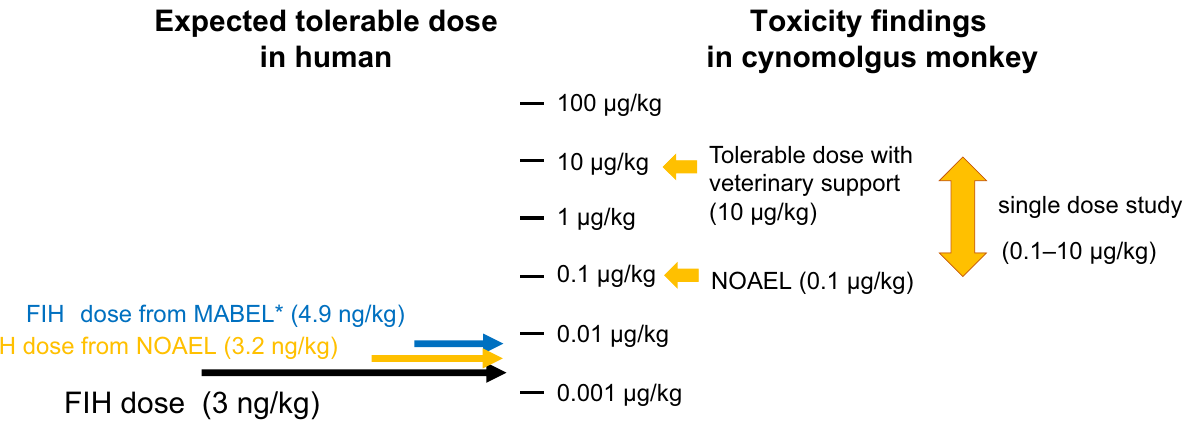
Figure 5. Calculation of the FIH dose from MABEL and NOAEL. The FIH dose from MABEL and NOAEL. The FIH dose from MABEL was calculated as the dose at which the C max after 4 h of i.v. infusion of ERY974 is equal to the EC 10 value of cytotoxicity assay, combining PK data, and the FIH dose from NOAEL was calculated considering species differences. FIH, first-in-human; MABEL, minimal anticipated biological effect level; NOAEL, observed adverse effect